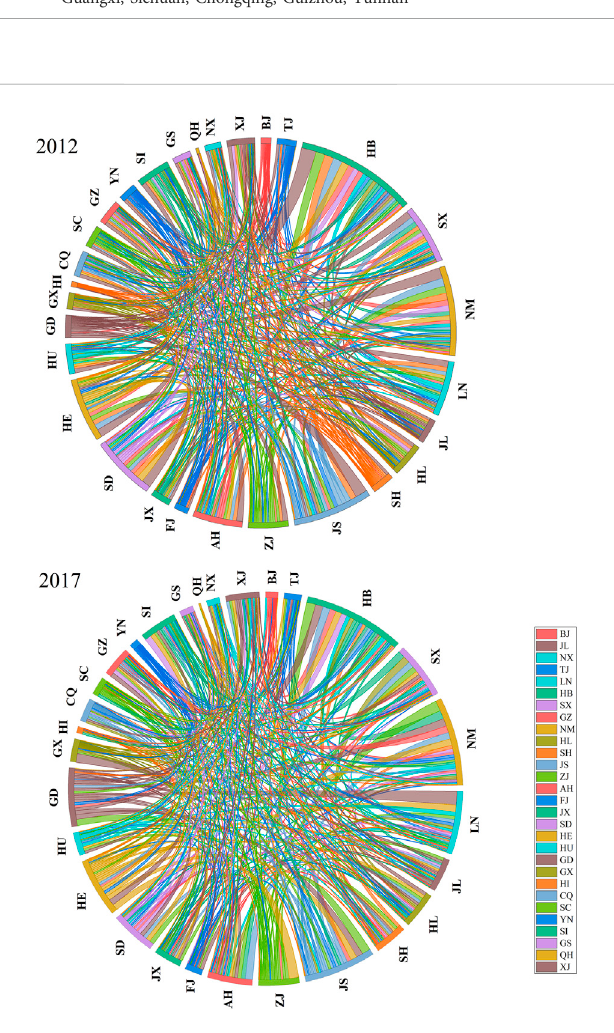
FIGURE 2 Chord chart ofembodiedcarbontransferbyprovincefrom 2012 to